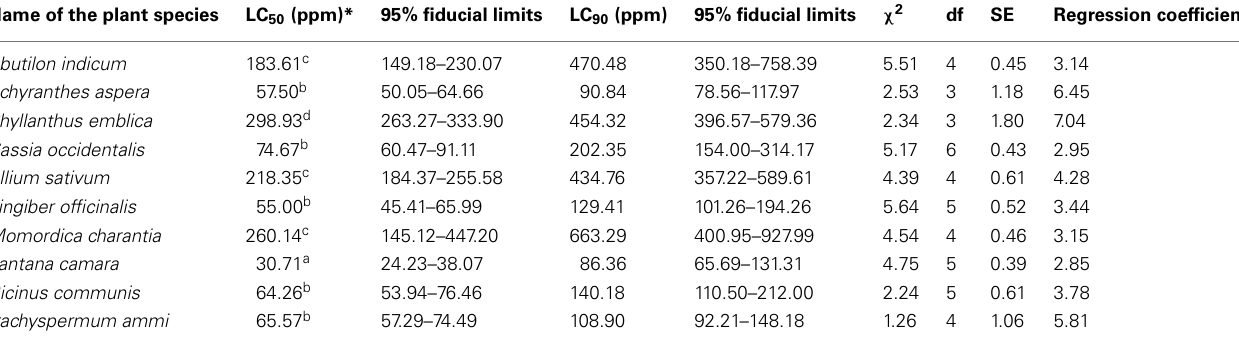
Table 2 | Larvicidal bioassay of crude hexane extracts of selected parts of 15 plant species against early fourth instars of Aedes aegypti . Name of the plant species